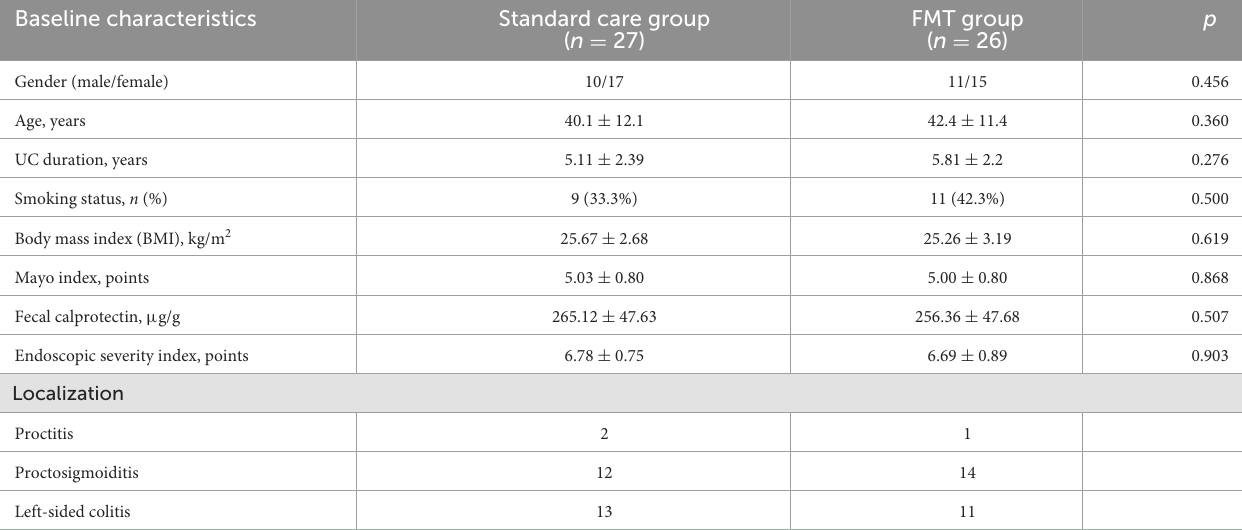
TABLE 1 Baseline clinical parameters in examined patients (M ± SD or